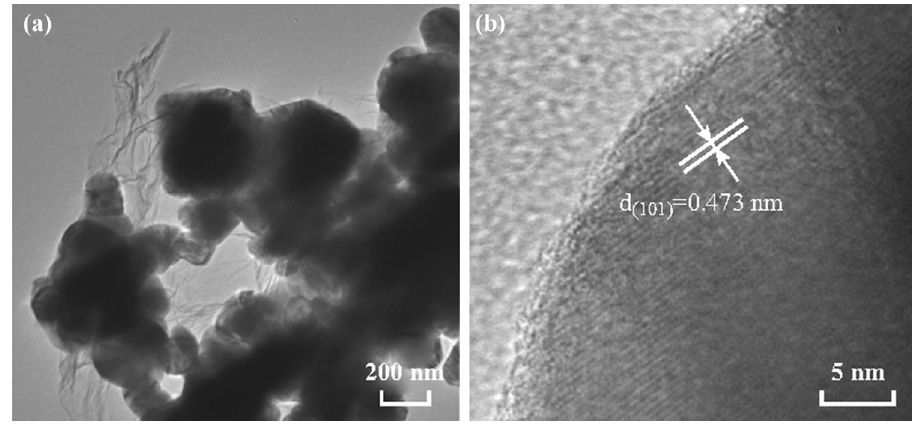
Fig. 3 TEM image of a CCO@rGO and b with corresponding HRTEM